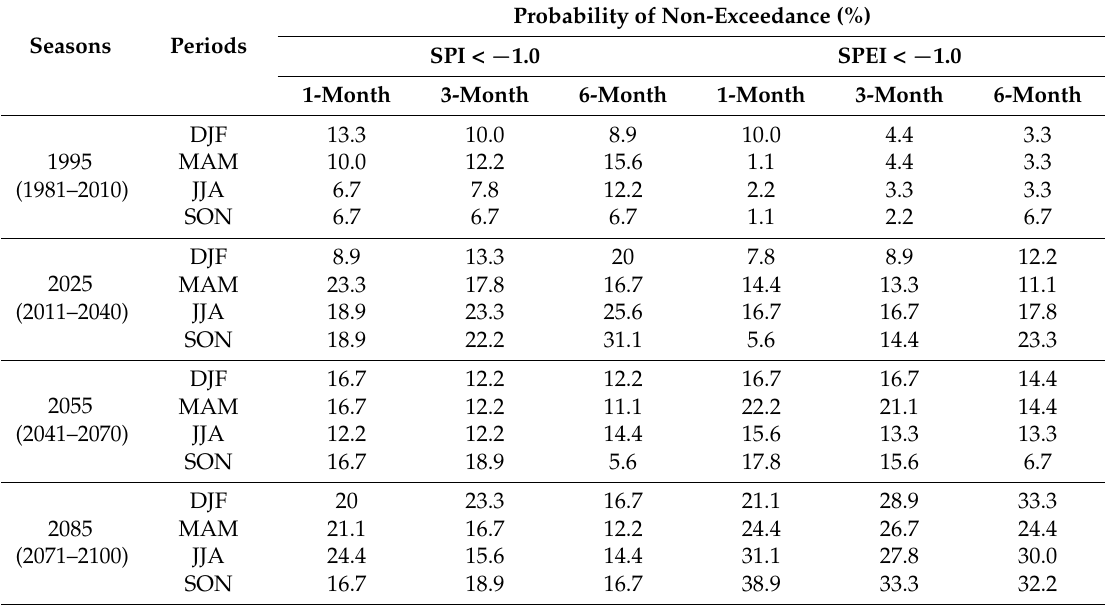
Table 4. Non-exceedance probability of multiple timescale SPI and SPEI below −